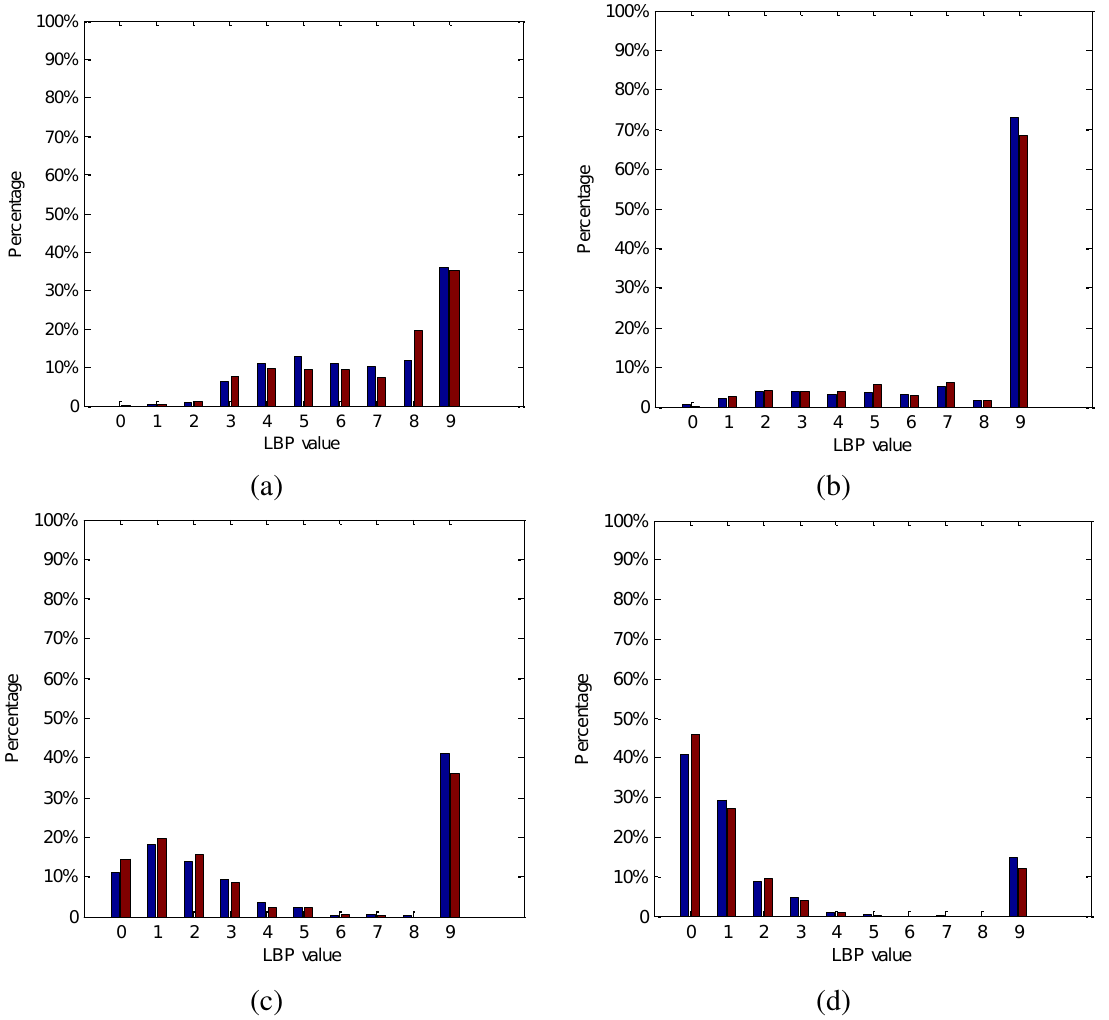
Figure 6. The LBP riu 2 and LBP riu 2 ,T value distributions of the homogenous regions in 8 , 1 8 , 1 Figure 4b: ( a ) RIU-LBP; ( b ) RHLBP (T = 10); ( c ) RHLBP (T = 20); ( d ) RHLBP (T =